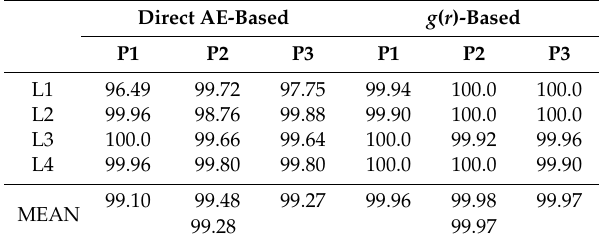
Table 11. Accuracy (%) of classifiers of two approaches by combined datasets. Direct